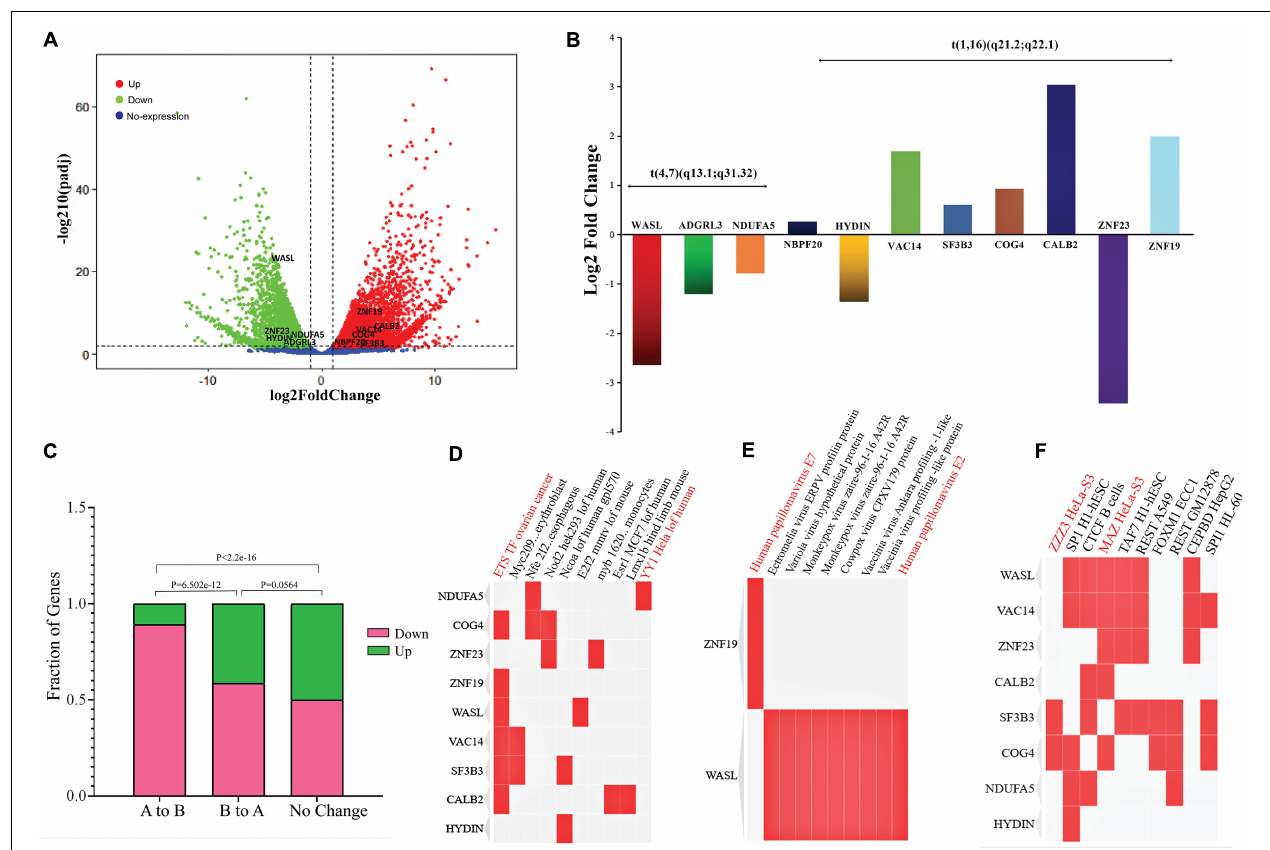
FIGURE 4 | RNA-Seq data results revealing the expression changes due to A/B compartments switching and in genes present around the translocations sites. (A) Volcano plot showing differentially expressed genes (DEGs); red dots: upregulated genes, green dots: downregulated genes, and blue dots: genes with no expression changes. (B) Expression changes of the genes (log2FC) present around t (4,7) (q13.1; q31.32) and t (1;16) (q21.2; q22.1); each gene is represented with a different color and the height of a bar indicates the Log2 fold change value. (C) Bar-plot shows the effects of A/B compartment switching on change in gene expression; the height of a bar represents the fraction of DEGs; green color: upregulated genes while deep pink: downregulated genes. (D–F) Clustergram of TF-lof expression of GEO enrichment library, Virus–Host Protein–Protein Interaction enrichment, and ENCODE TF ChIP-seq libraries, respectively. Enrichment terms are shown in each column, each row indicates the candidate genes, and matrix shows the association between gene and types of enrichment term. Red color indicates the terms directly or indirectly associated with female cancers (cervical cancer/ovarian